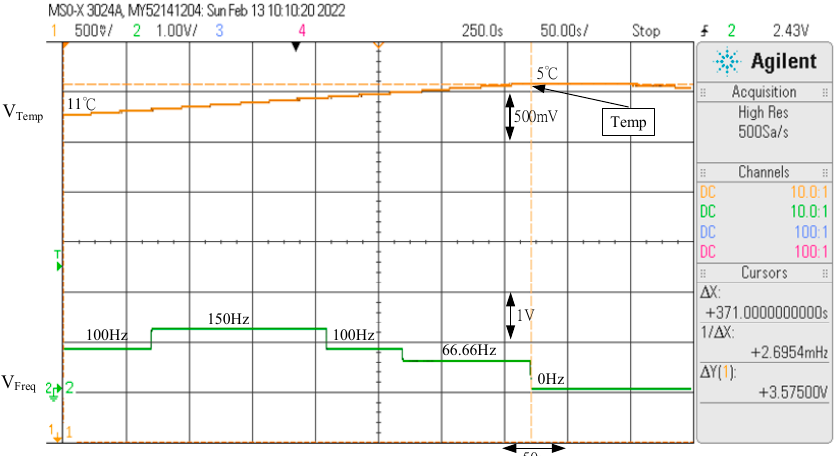
Figure 31. Response waveform of the temperature control with the proposed extension controller (control the temperature to change from 13 °C to 5 °C).